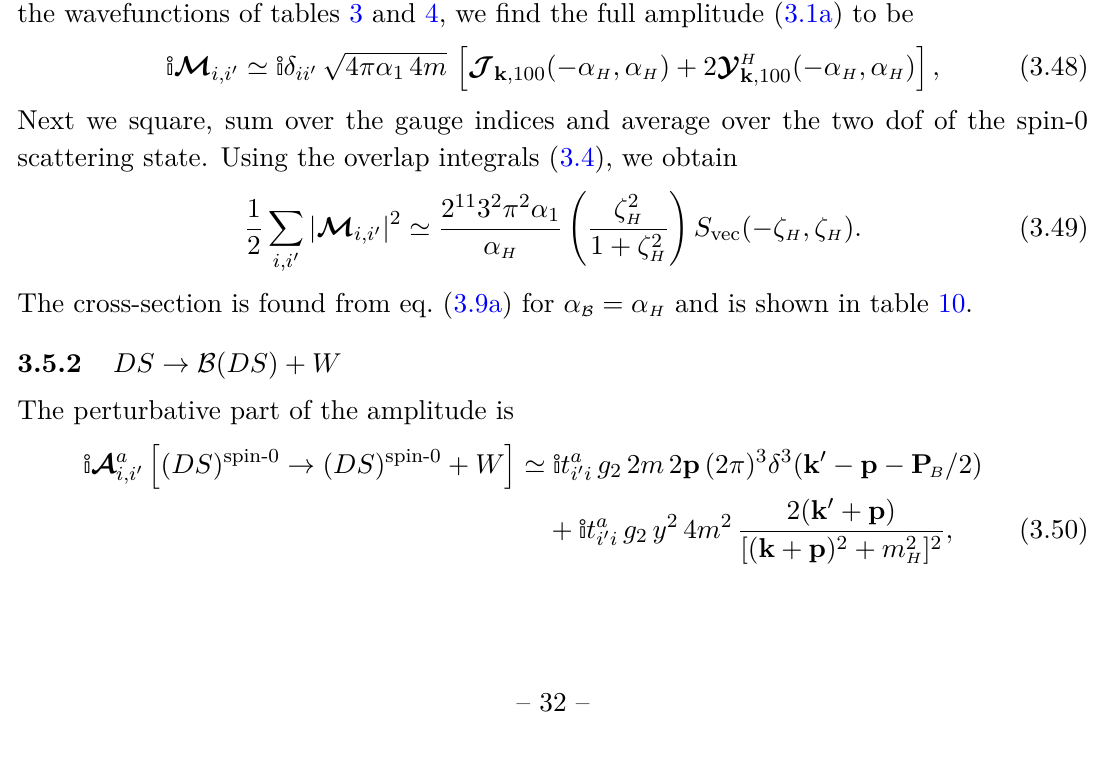
= s = 0 . Here, ω = m ( α 2 S